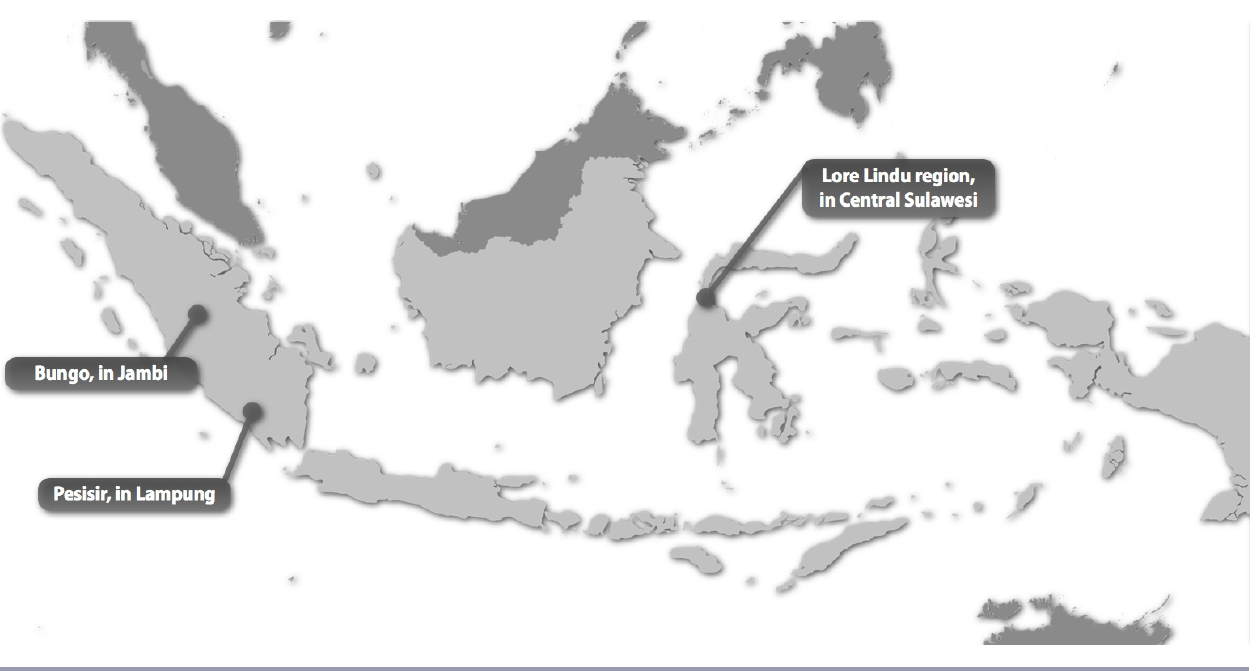
Fig. 1 . Location of the three study sites in